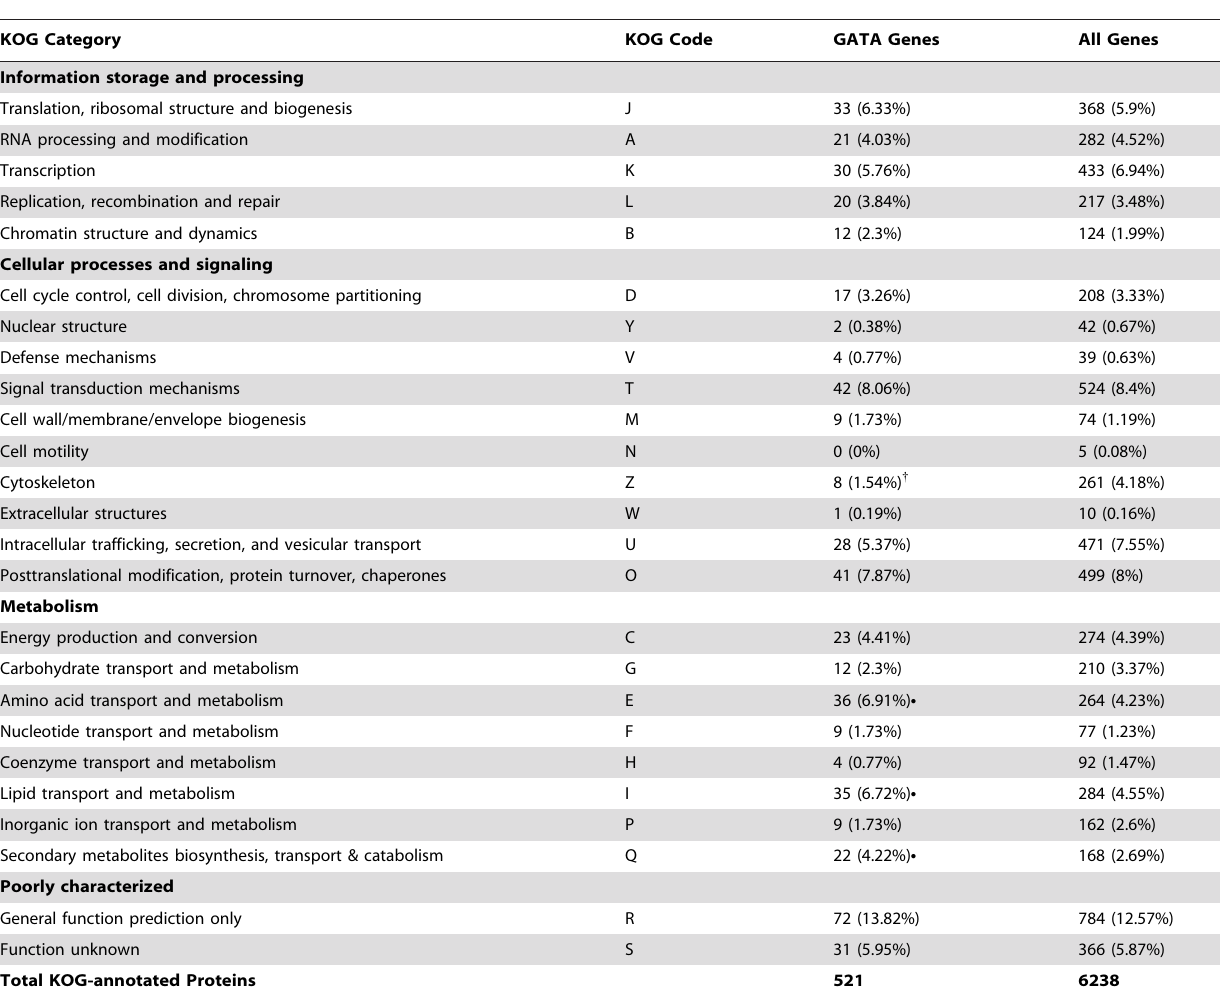
Table 1. Enrichment of GATA-containing genes in B. dermatitidis according to KOG